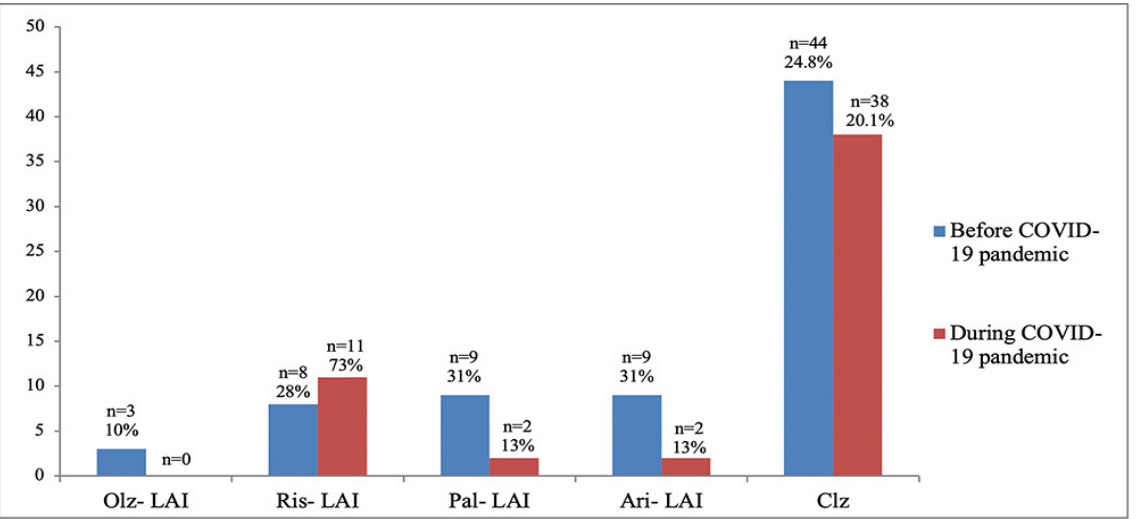
Figure 3. LAIs and clozapine initiations in 2019 vs. 2020. Olz-LAI-olanzapine long acting injectable; Ris-LAI-risperidone long acting injectable; Pal-LAI-paliperidone long acting injectable; Ari-LAI-aripiprazole long acting injectable; Clz-clozapine.